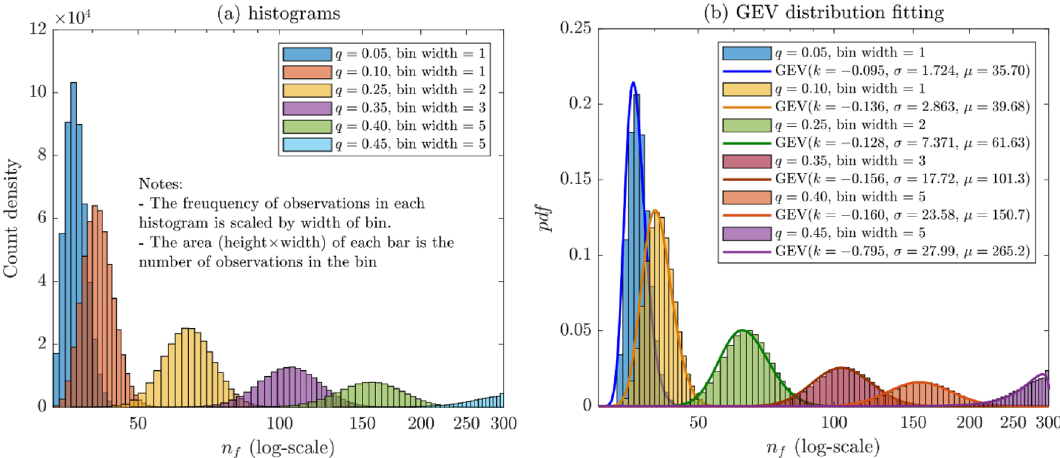
: mean number of crack segments going sideways (left or right) before s